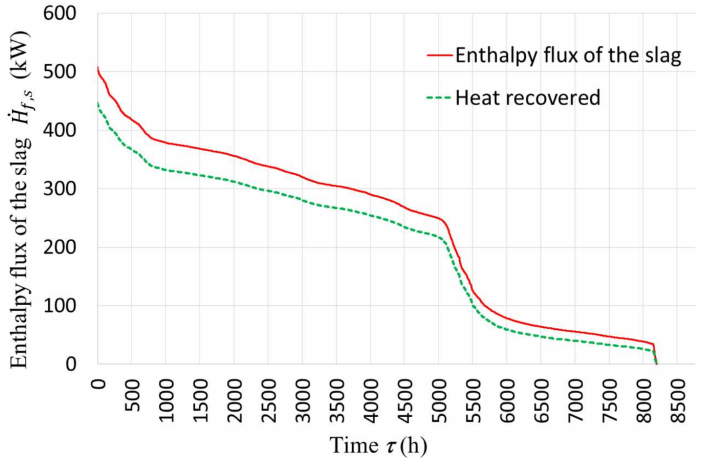
Figure 16. Annual distribution curve of enthalpy flux of the analyzed